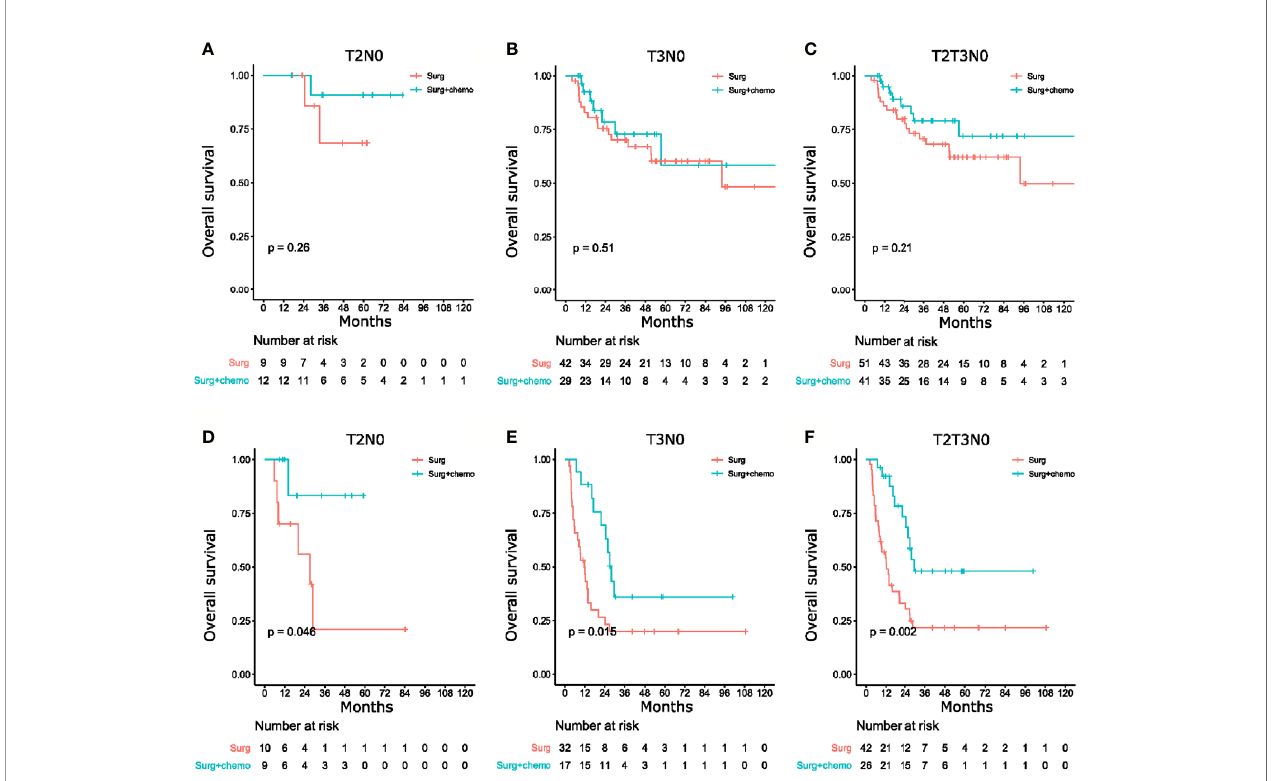
FIGURE 4 | Kaplan-Meier curves of overall survival for patients with surgery only versus surgery and chemotherapy. (A) T2N0 patients with good prognosis, (B) T3N0 patients with good prognosis, (C) T2N0 and T3N0 patients with good prognosis, and (D) T2N0 patients with poor prognosis, (E) T3N0 patients with poor prognosis, (F) T2N0 and T3N0 patients with poor